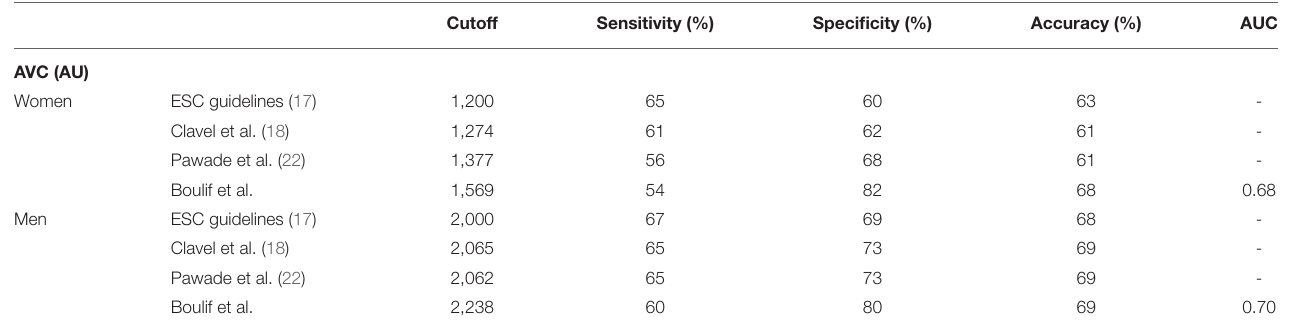
TABLE 7 | Prognostic accuracy of severe calcification in patients with concordant echocardiographic grading.